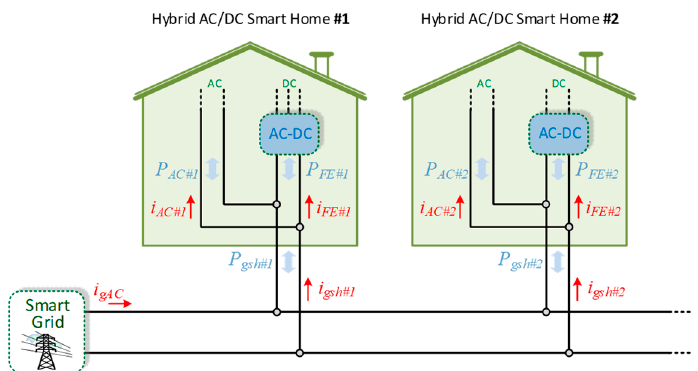
Figure 5. Structure considered for the experimental validation including two front-end AC/DC converters for emulating two hybrid AC/DC smart homes.